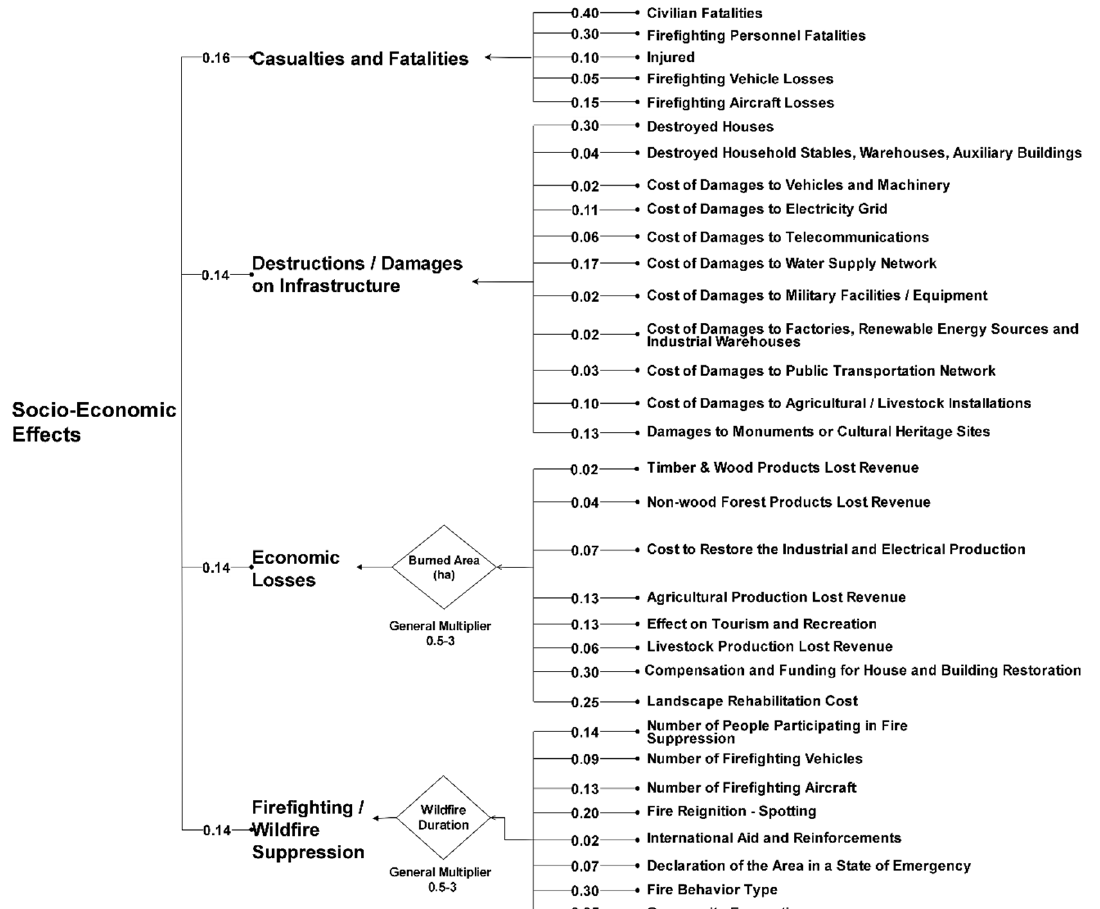
Figure 2. Flowchart of how the 32 criteria attributed to the evaluation of socioeconomic fire effects group were assigned to the three fire effect categories. Numbers denote the weight of each criterion and category, as derived by the expert evaluation of relative criterion importance analysis with the analytical hierarchical process (see Sections 2.3 and 2.4). General multipliers are described in Section 2.2.3.